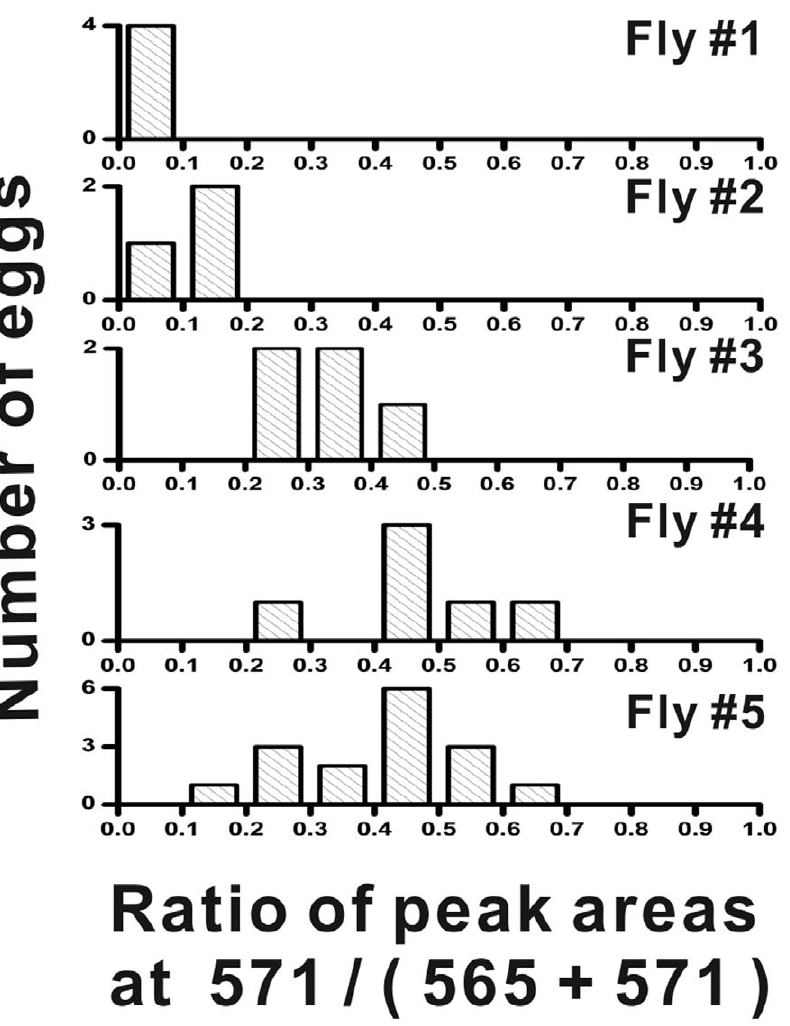
Figure 6. Histograms showing differences in the labeling of eggs among flies from the same treatment. Flies incubated during night (starting from the evening) at dark (ED): arbitrarily selected examples of five single-fly histograms, ordered according to the increasing level of labeling (Fly # 1 to # 5: top to bottom). All single-fly histograms from this experimental variant are displayed in Figure S9 .